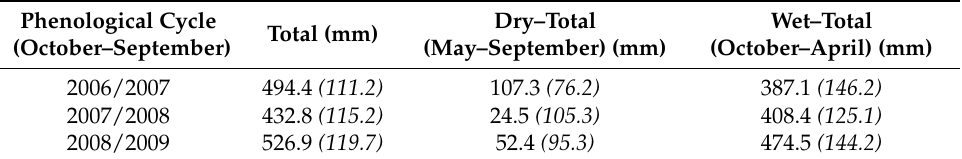
Table 1. The total rainfall for each phenological cycle, as well as for each dry and wet period within each cycle. The mean coefficient of variation (%) for each period is presented in brackets. The values were extracted from seven weather stations within the region of study.